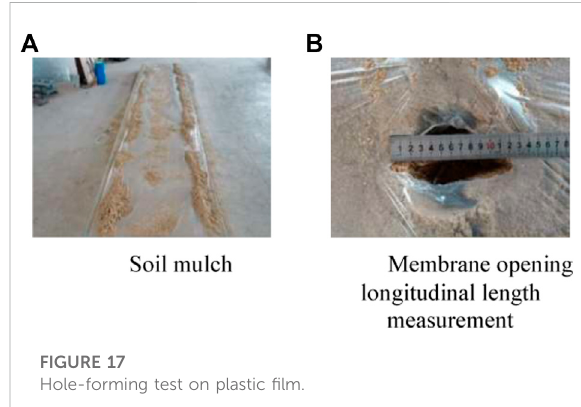
FIGURE 17 Hole-forming test on plastic fi lm.